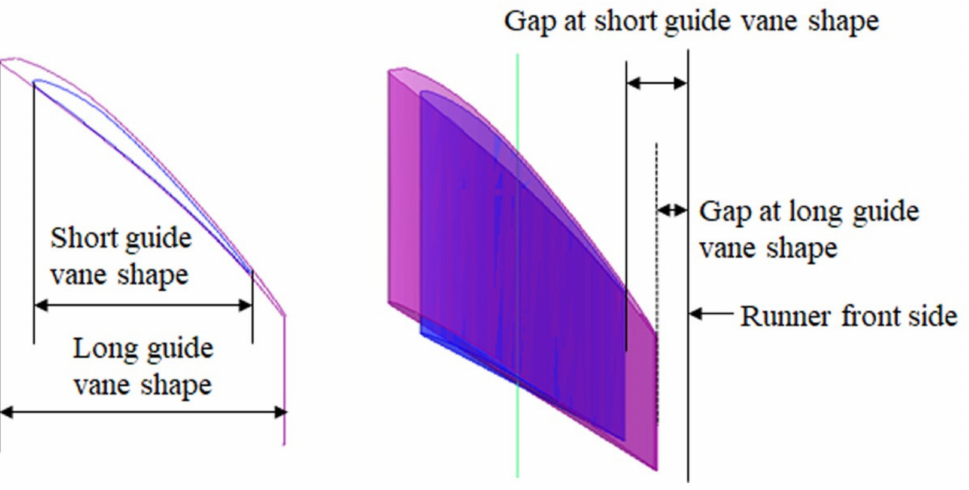
Figure 17. Shapes of short and long guide vanes.